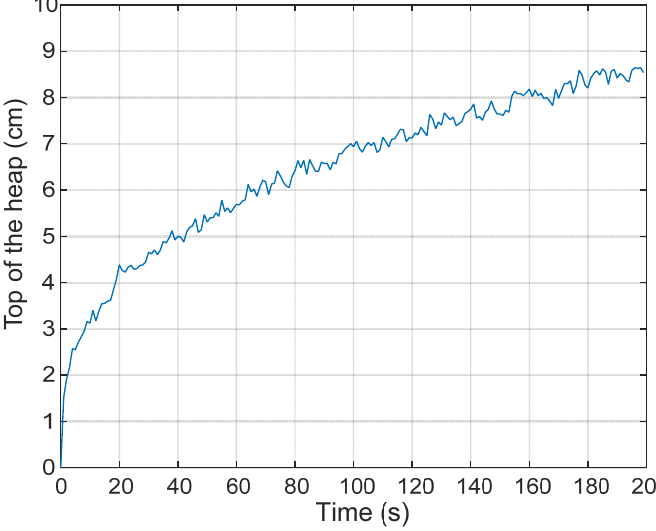
Figure 2. Heap top ℎ(cid:4666)𝑡(cid:4667) variation. Figure 2. Heap top h ( t )